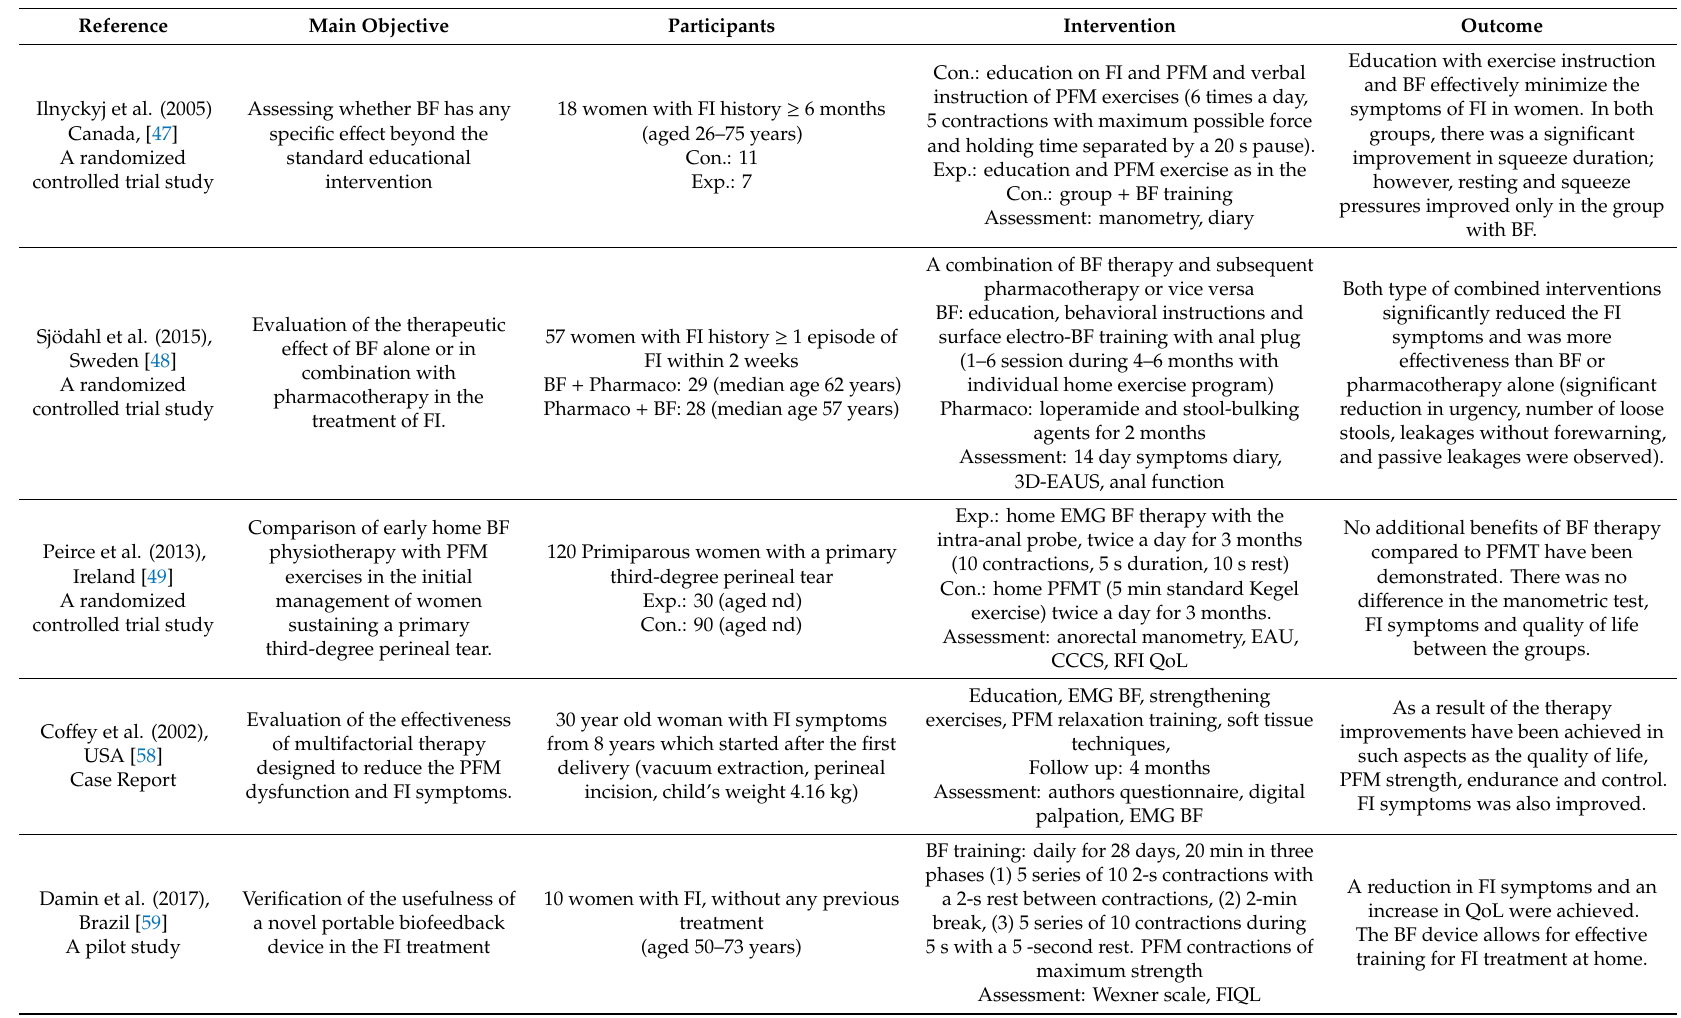
Table 6. Characterization of selected studies on the e ff ects of the biofeedback (BF) technique on the severity of fecal incontinence